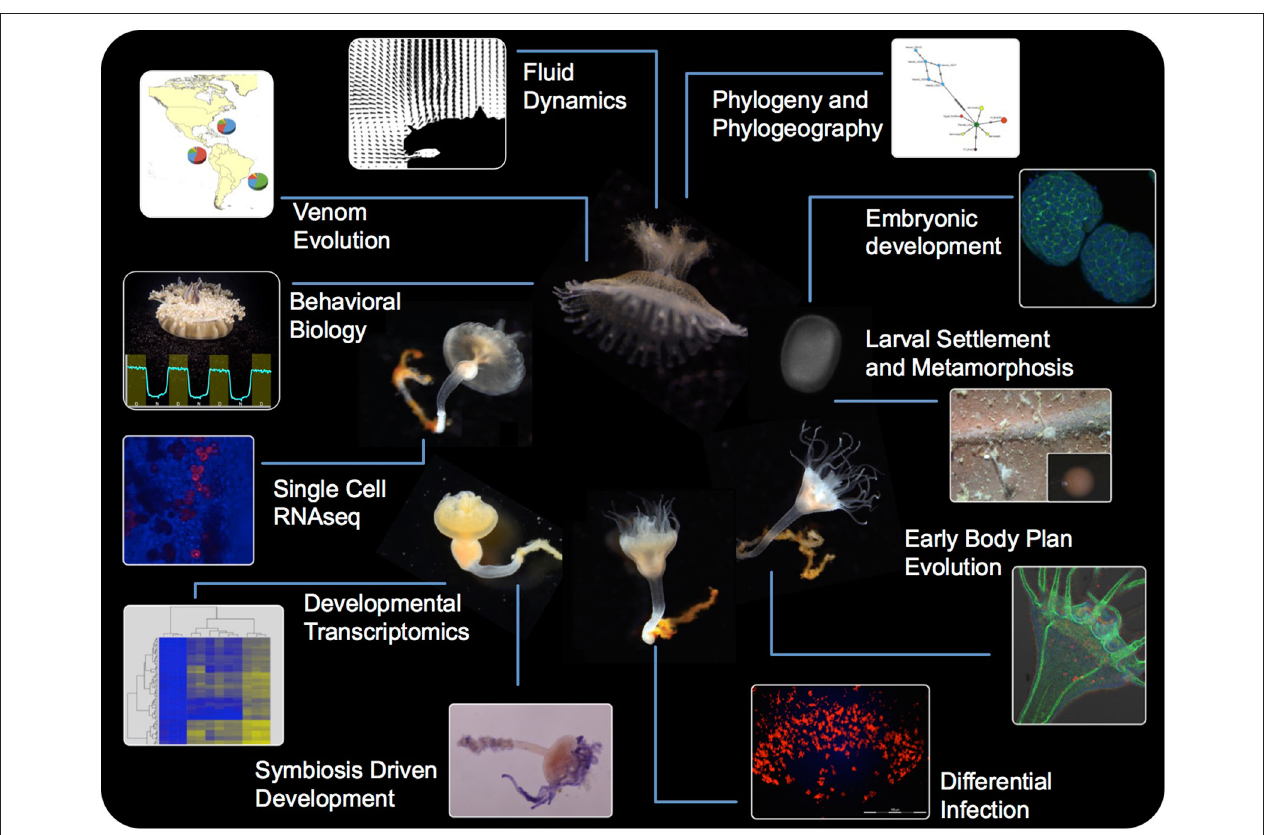
FIGURE 1 | A schematic summarizing the tools and approaches available for the Cassiopea system, highlighting the utility of each life stage toward a multidisciplinary approach to understanding the biology and physiology of this early metazoan.